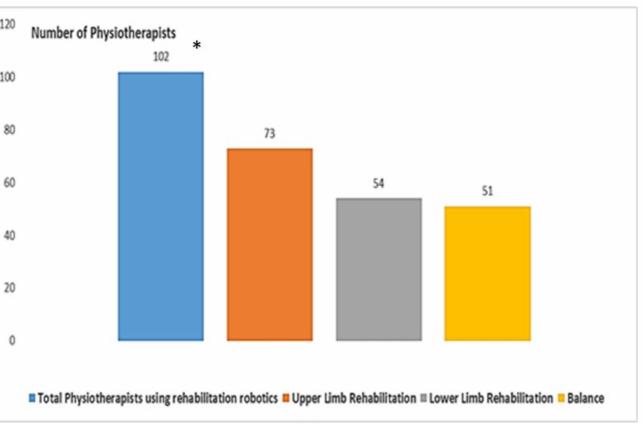
Figure 3. Use of rehabilitation robotics in the workplace (* 102 is different from the sum of the three choices, because it is a multiple-choice question)